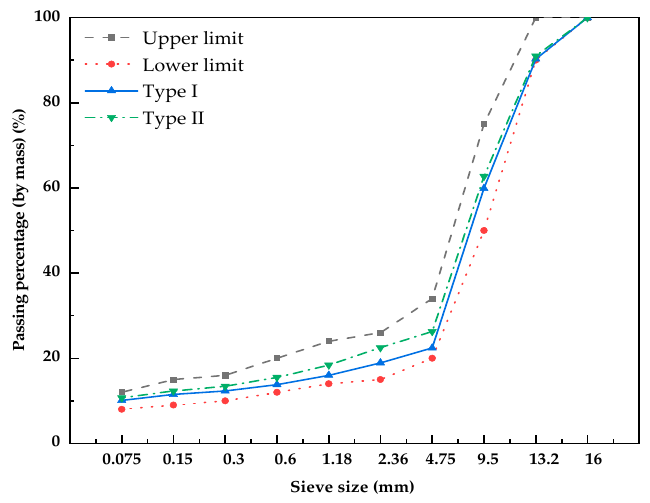
Figure 3. Gradation of two types.